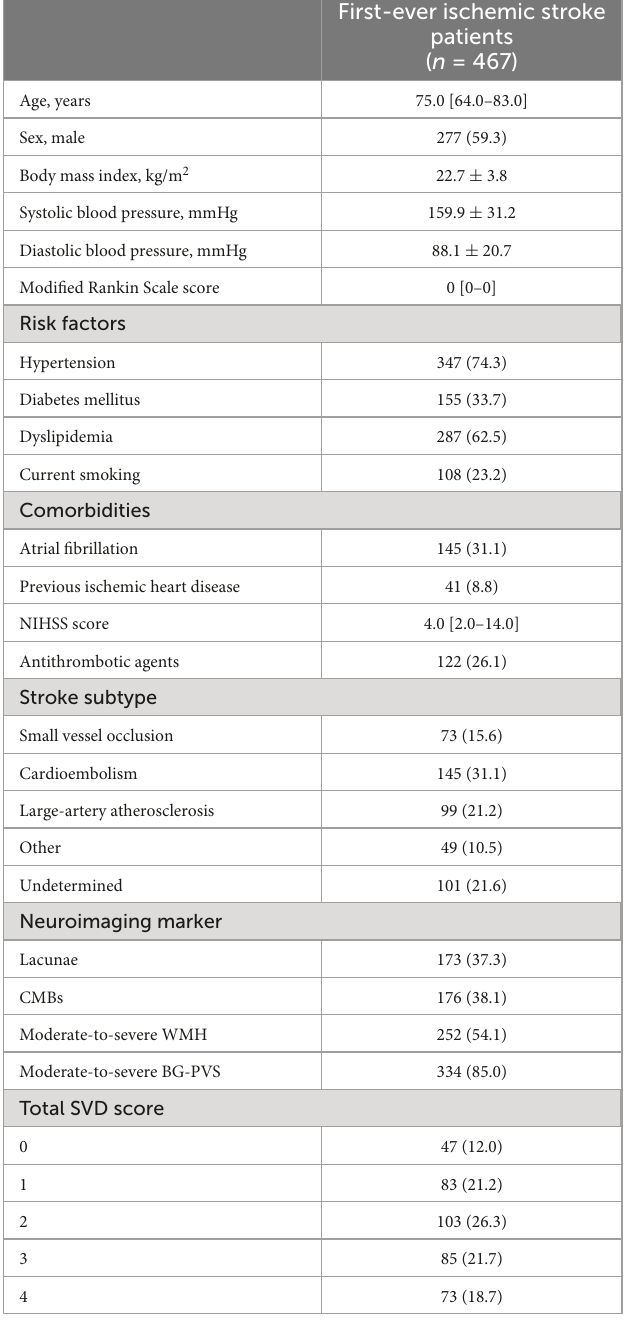
Bodymassindexdataaremissingfor10patients,diabetesmellitusfor7,dyslipidemiafor8,and current smoking for 1. Total SVD score were evaluated for 391 patients. BG-PVS, perivascular spacesinbasalganglia;CMBs,cerebralmicrobleeds;NIHSS,NationalInstitutesofHealthStroke